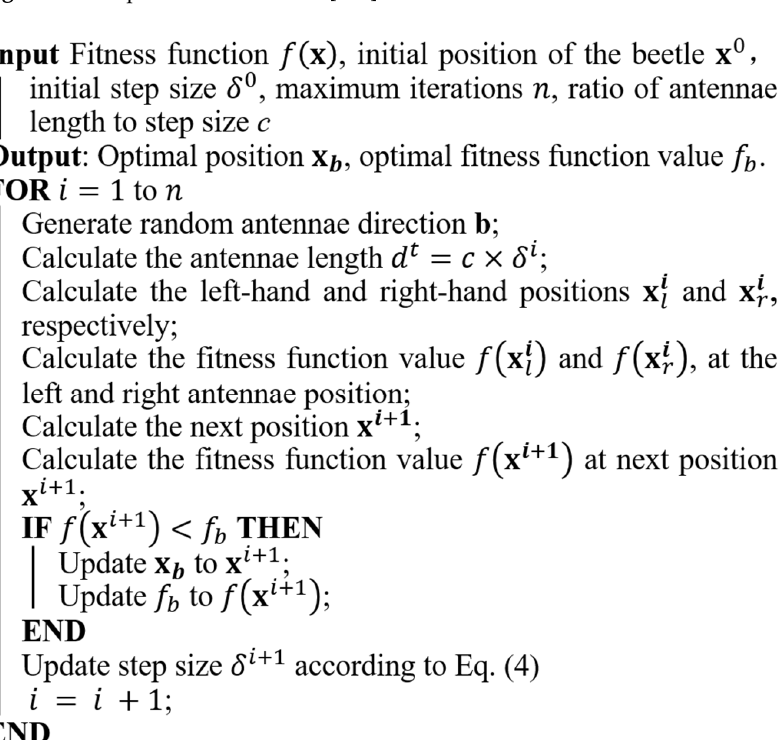
Figure 13. Simplified beetle model [104].